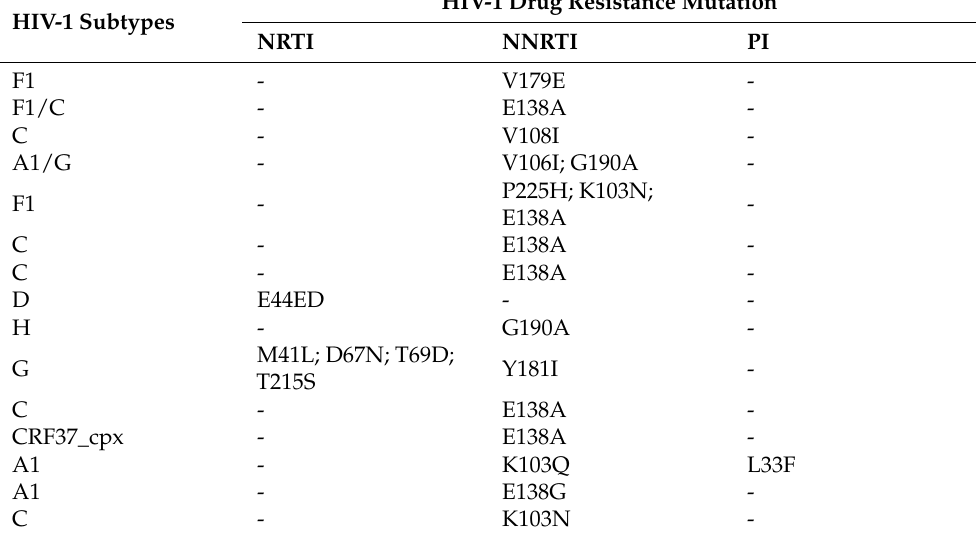
A1, G, D, H, F1/C, A1/G, H/G, CRF02_AG, and CRF37_cpx were